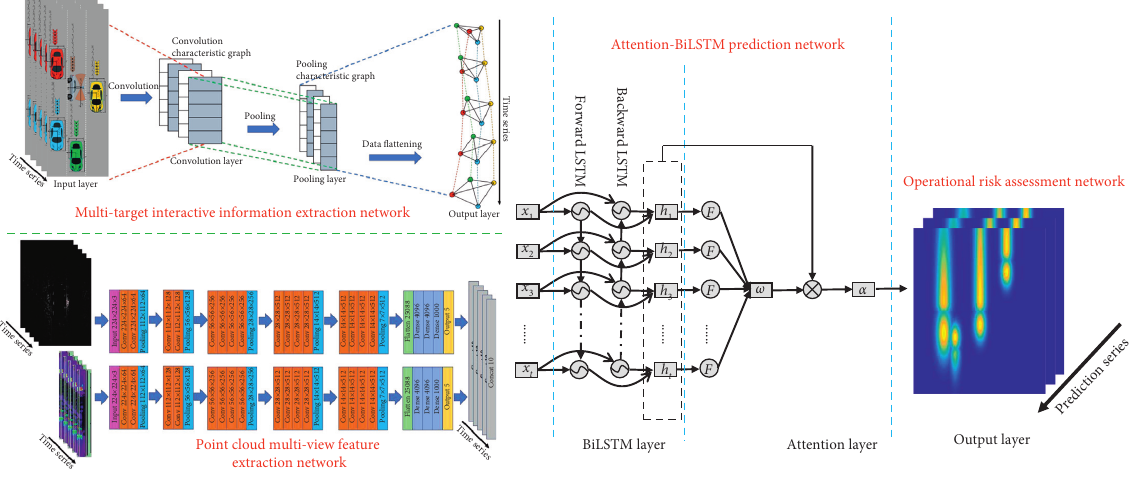
Figure 4: The prediction model of the operational risk of intelligent vehicles that integrates multiview point cloud and multitarget in- teraction